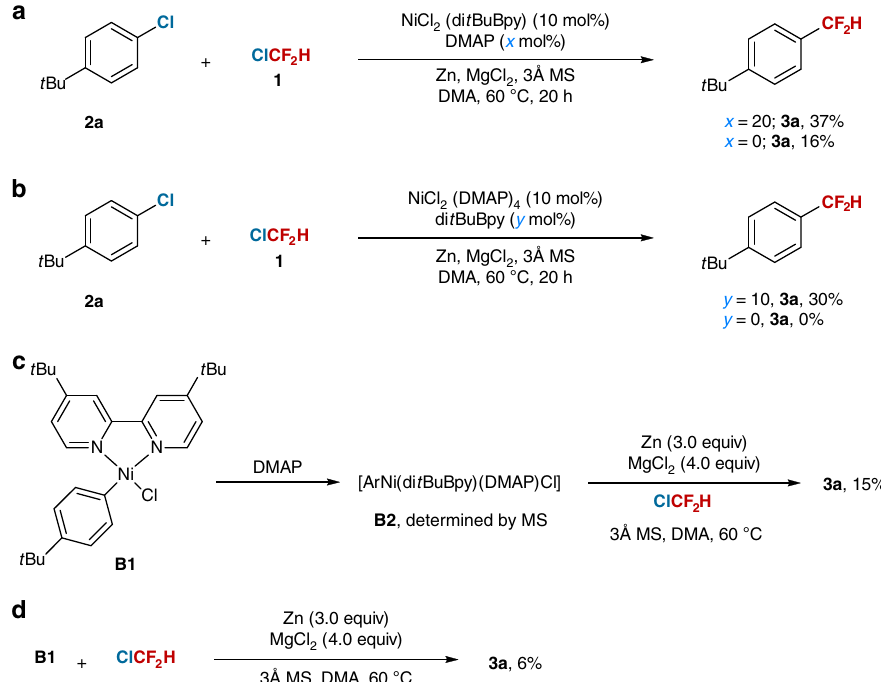
Fig. 5 The role of DMAP. a [NiCl 2 (di t BuBpy)] ( D1 ) catalyzed reaction between 2a and 1 with or without DMAP. b [NiCl 2 (DMAP) 4 ] ( D2 ) catalyzed reaction between 2a and 1 with or without di t BuBpy. c Reaction of B1 with ClCF 2 H in the presence of DMAP. d Reaction of B1 with ClCF 2 H without DMAP